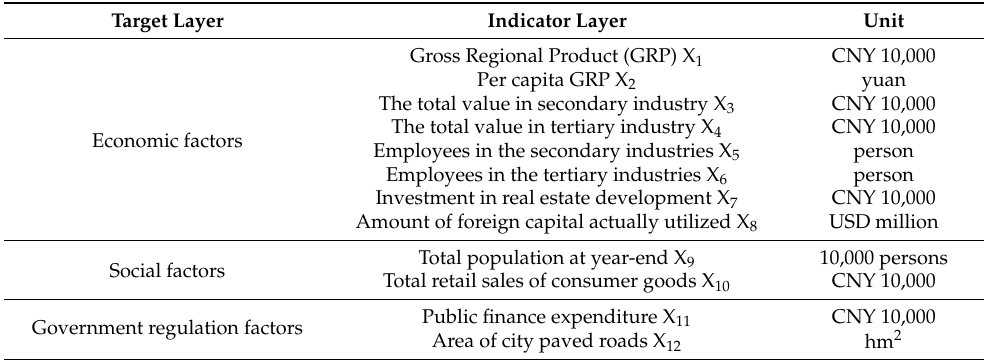
Table 1. The driving factors of